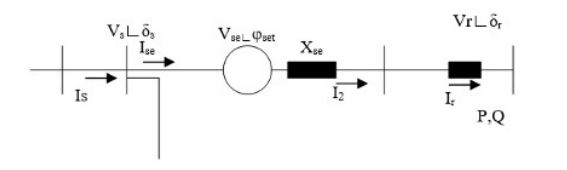
Figure 3. Single Line Diagram of Power Transmission System with